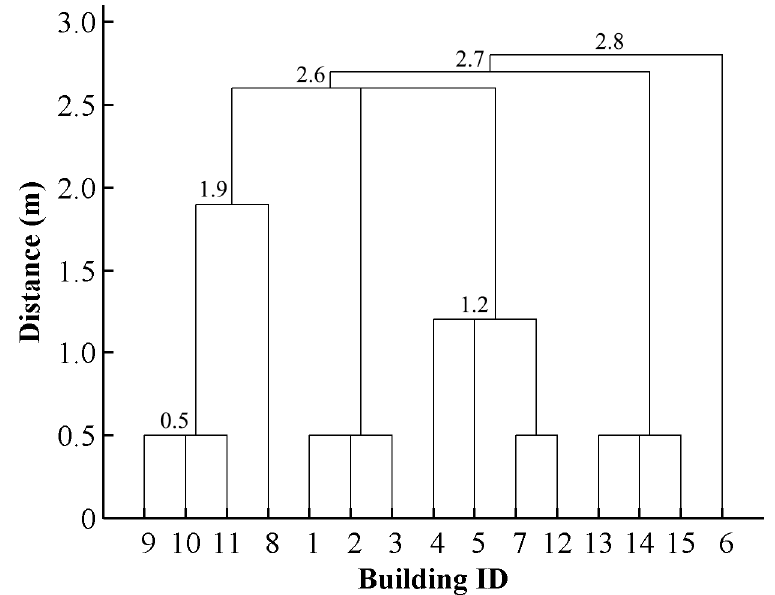
Figure 12. The hierarchy of a building cluster inside Block 1. The maximal distance of each subgroup is used to quantify the scale parameter. Those subgroups with a distance value less than a given threshold form a scaling grouping result. In the hierarchy, nodes denote building subgroups, and the connected lines between nodes represent their hierarchical relationships.